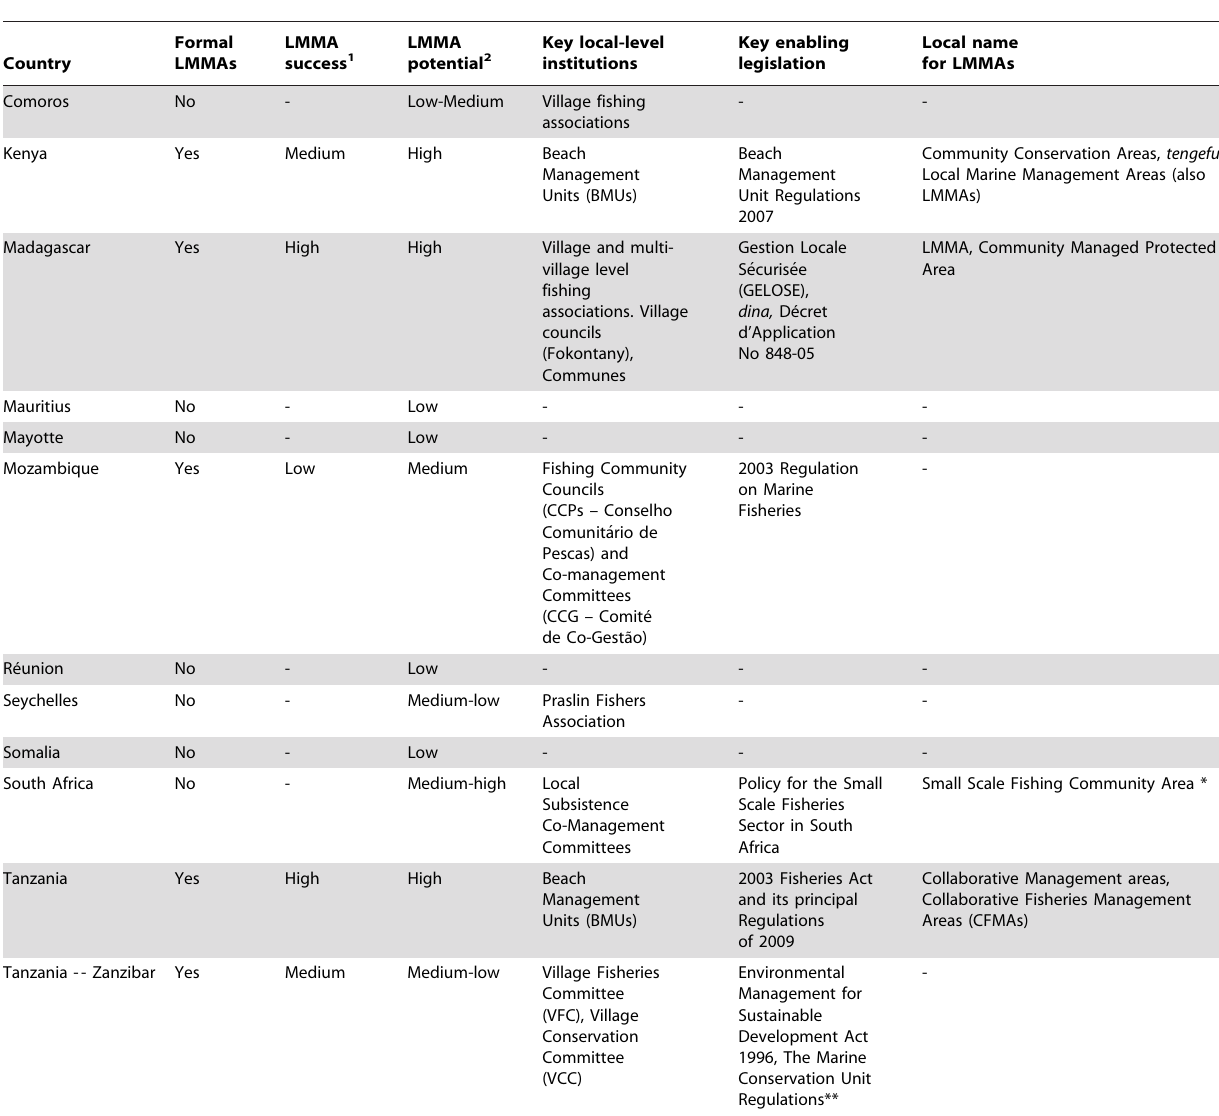
Table 5. Key features of LMMA initiatives in the Western Indian Oceans.